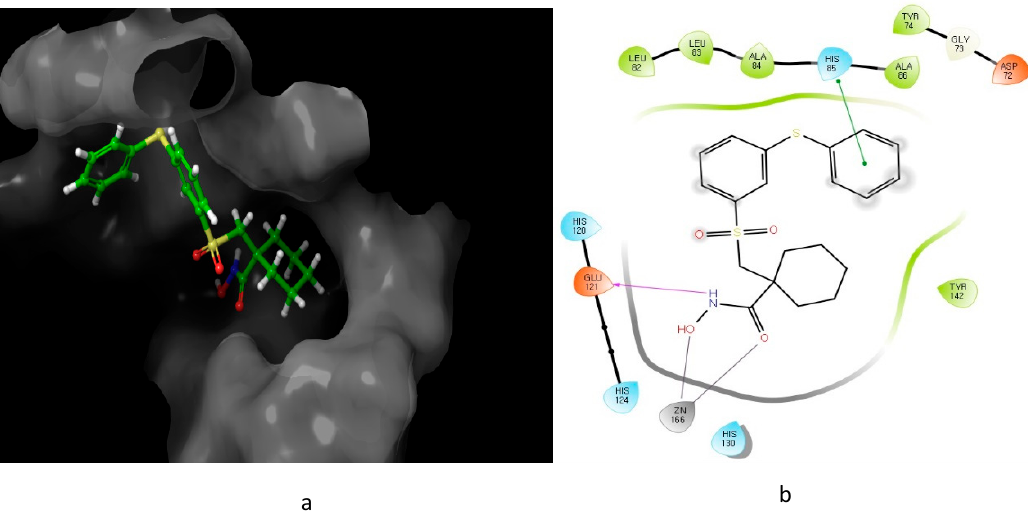
Figure 5. Predicted interaction of β -sulfone ( 11 ) derivative active site residues of MMP. ( a ) 3D structural view of ligand inside the receptor’s active site. ( b ) Ligand interaction diagram; violet lines represent hydrogen bonds, green lines represent π – π interactions, and grey line represent metal interactions.